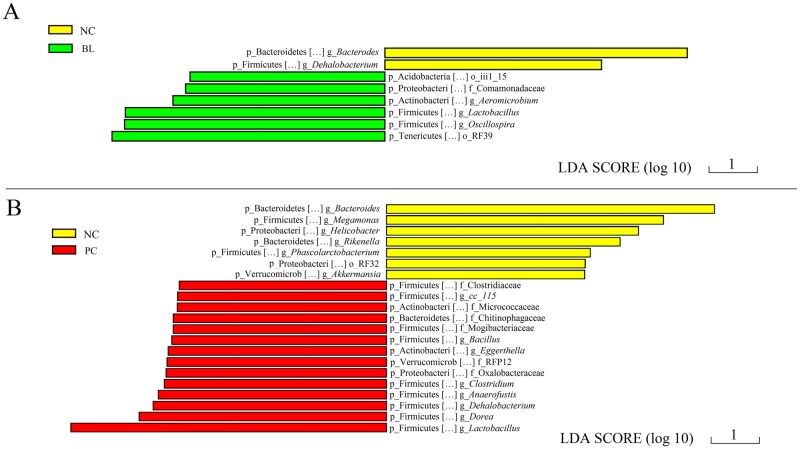
Taxa that were significantly differentially represented in the control group compared with the groups that had C. perfringens, Eimeria challenge and fishmeal supplementation, with and without Bacillus licheniformis treatment.(A) Differentially overrepresented taxa in group NC versus group BL. (B) Differentially overrepresented taxa in group NC versus group PC. Phylum and genus level names are shown. Sequences that could not be classified at the genus level were named according to the next highest level. NC, negative control; PC, treated with C. perfringens, coccidia, and fishmeal; BL, pre-treated with B. licheniformis then treated with C. perfringens, coccidia, and fishmeal.